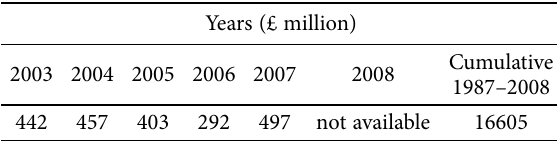
Table 1. The PFI signed transport project sector breakdown